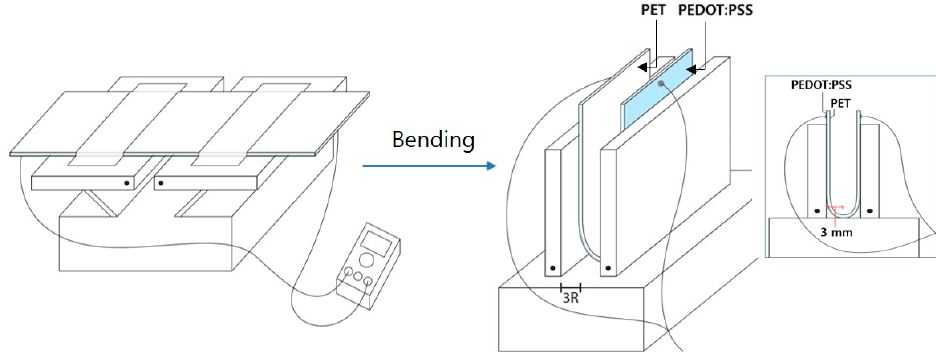
Figure 1. Schematic illustration of cyclic bending test. The insert illustrates a bended film viewed from the side.